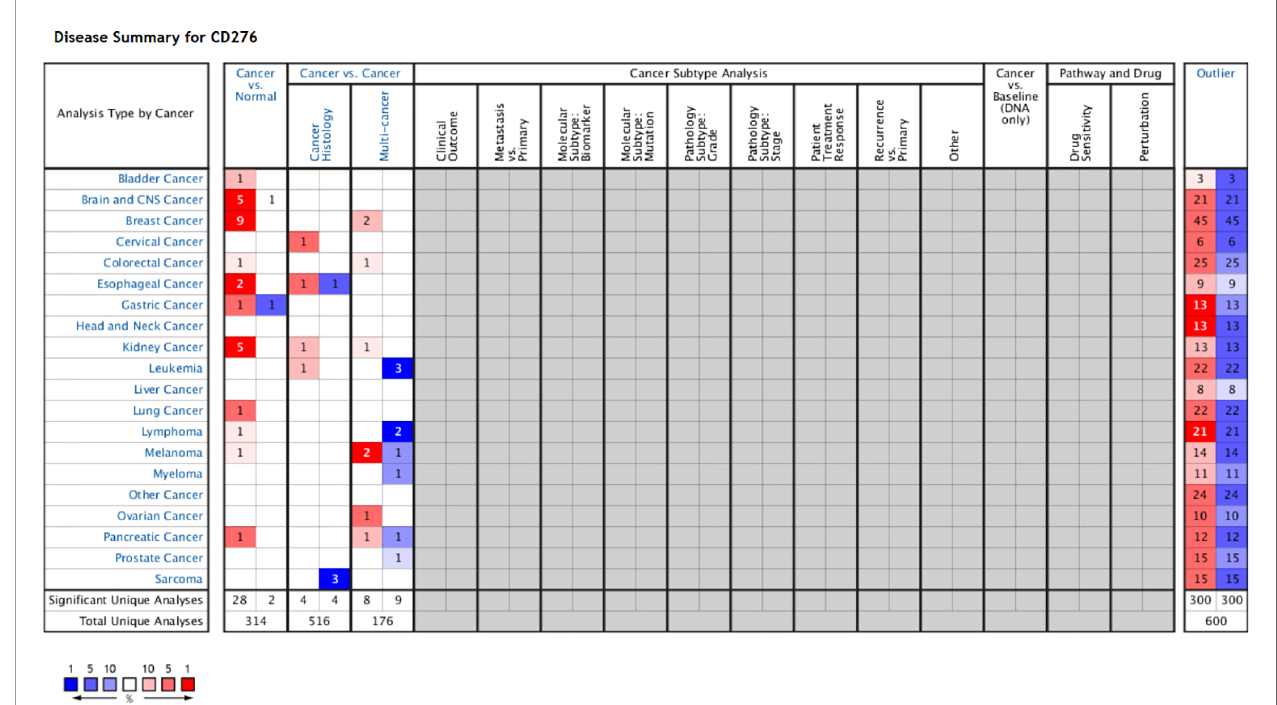
FIGURE 1 | B7-H3 differential expression datasets in distinct cancers. P-value equals 0.05, fold change equals 2, red indicates high expression, and the darker the color, the higher the expression, blue indicates vice versa (only comparisons within the same row). Gray and blank means no data. Cell color is determined by the best gene rank percentile for the analyses within the cell (Note: an analysis may be counted in more than one cancer type).